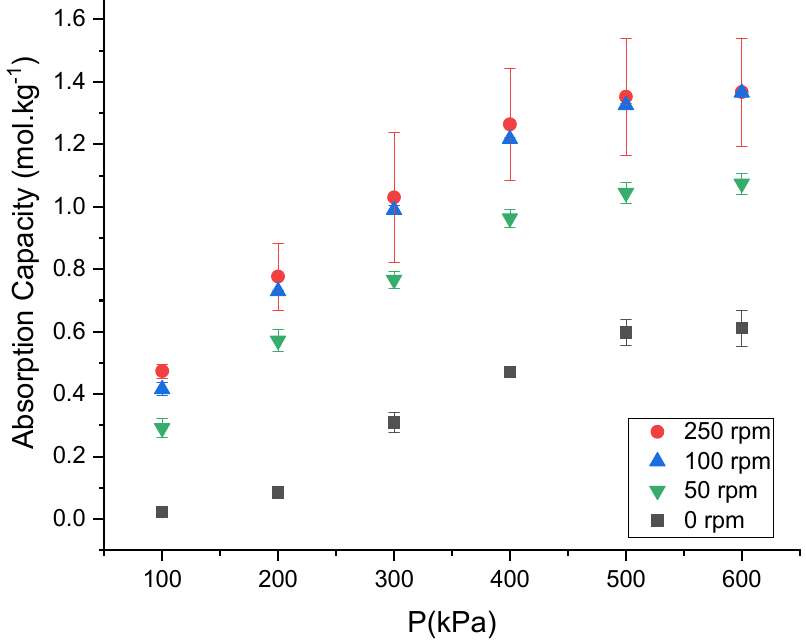
Figure 5. CO 2 absorption capacity of ChCl:LvAc (1:2:0) at 0, 50, 100 and 250 rpm at 25 °C. At 6 bar and 25 °C, the CO 2 absorption capacity of ChCl:LvAc (1:2:0) increased from 0.61 mol·kg − 1 under stagnant conditions up to 1.37 mol·kg − 1 under strong (max) stirring at 250 rpm. The CO 2 absorption capacity increases strongly with increasing stirring speeds